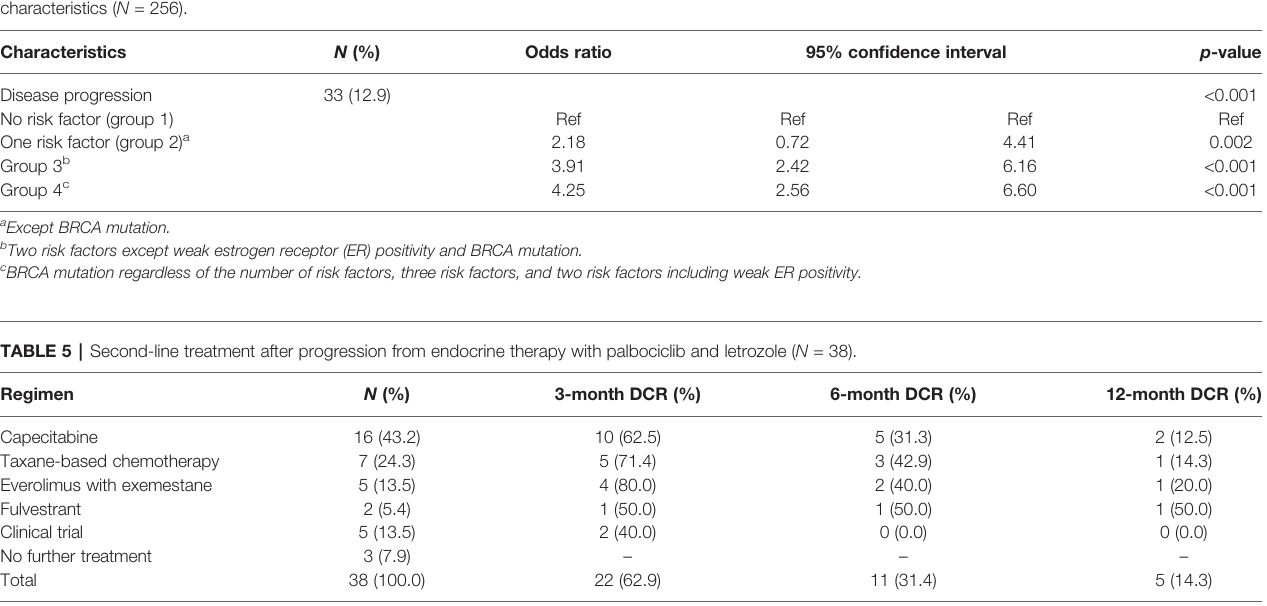
Total DCR, disease control